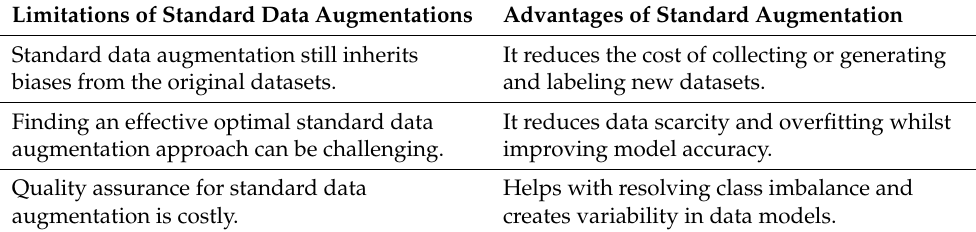
Table 1. Limitations and advantages of the standard